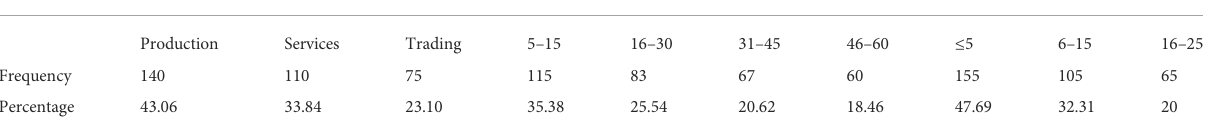
TABLE 1 Sampling pro fi le and